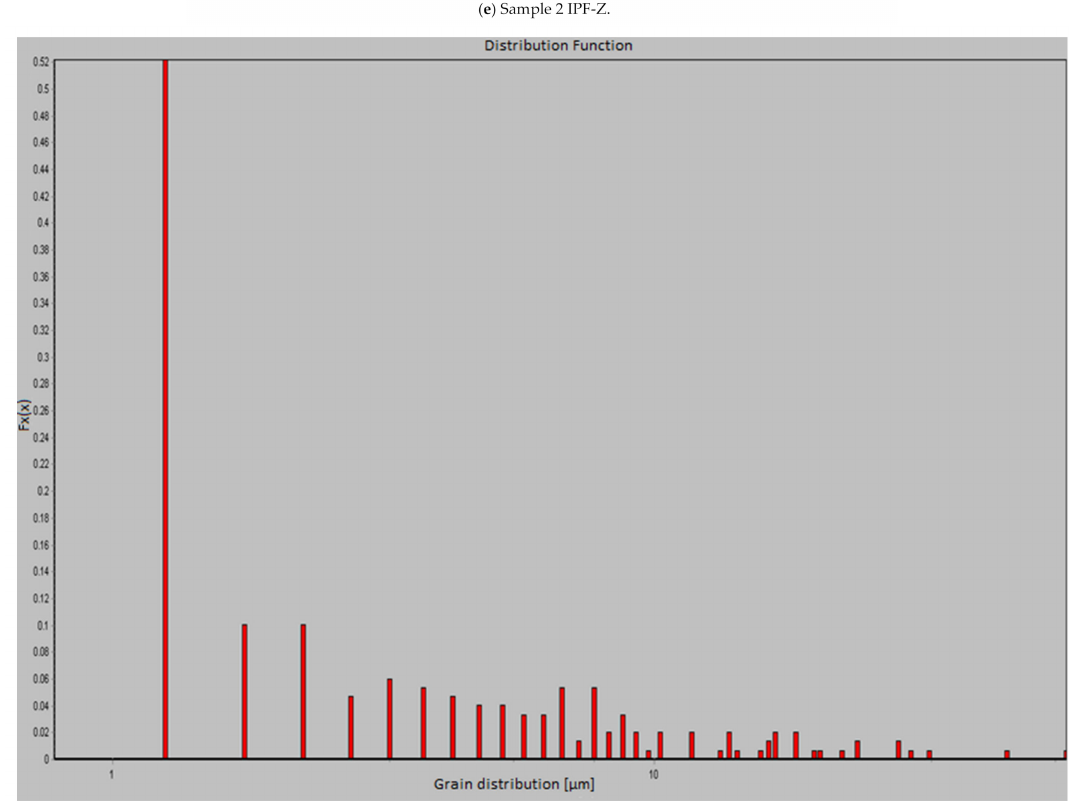
Figure 5. ( a – c ) describe the electron backscatter diffraction showing black lines as high angle grain boundaries >15 ◦ and grain size distribution in the plane measured for sample 1. ( d – f ) describe electron backscatter diffraction showing black lines as high angle grain boundaries (HAGBs) >15 ◦ and grain size distribution in the plane measured for sample